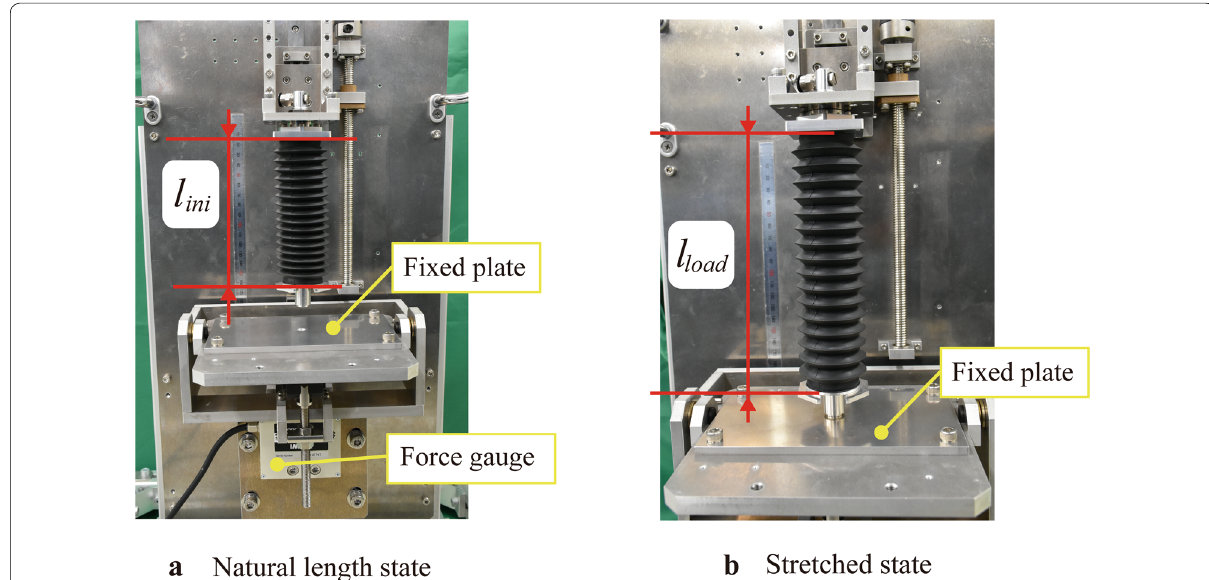
Fig. 20 Experiment of load and stretch length of the bellows pneumatic actuator with a ring member inside. a Natural length state, b stretched state